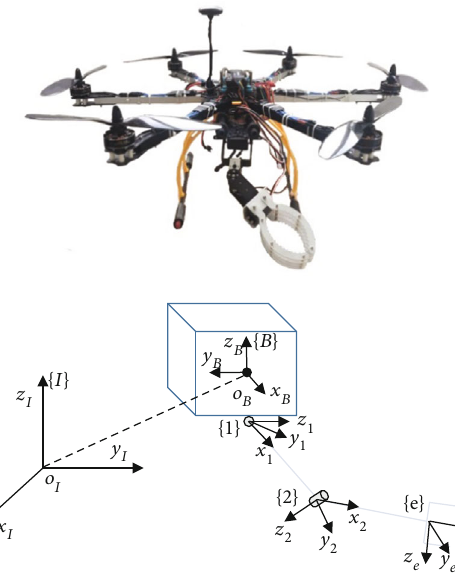
Figure 1: Reference frames and vectors of our